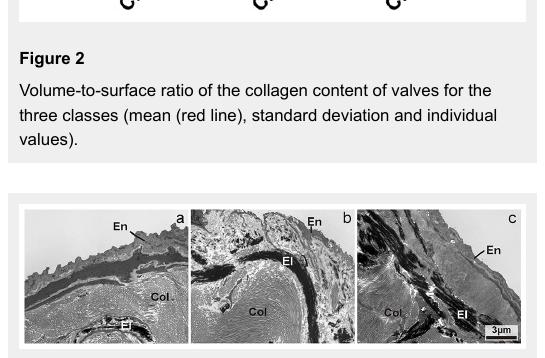
Transmission electron microscopic image of endothelial damage on the valve surface with increasing severity from a to c: a) normal endothelial cells; b) swollen and necrotic appearance of the endothelial cells; c) denuded valve surface with absent endothelial cells. En: endothelial cells, BM: basal membrane. Magnification: 4400x.